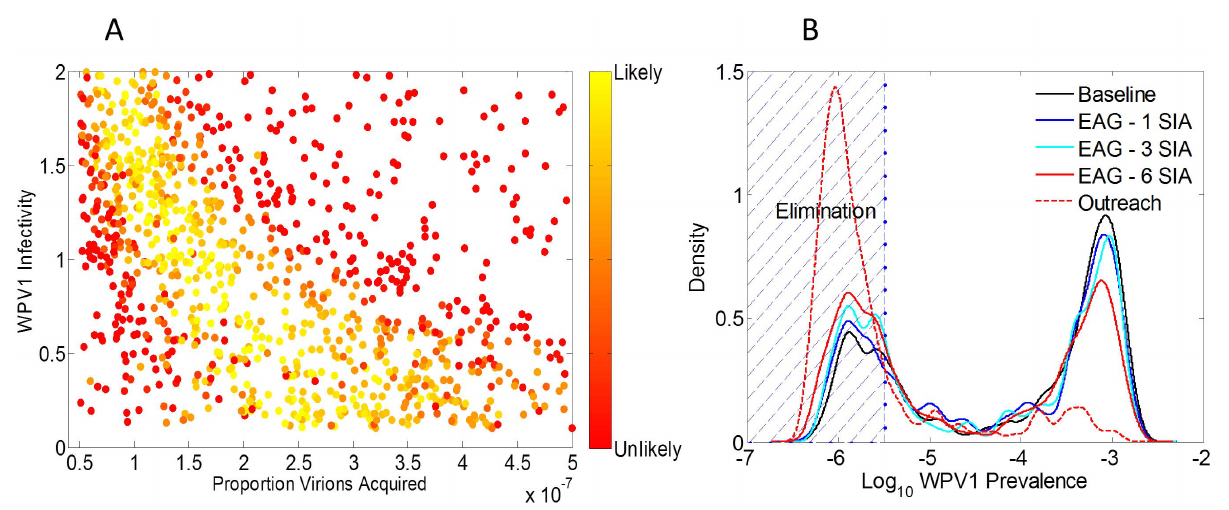
Figure 2. Model calibration and the effect of both expanding age groups and targeting in SIA campaigns. (A) Likelihood of polio infectiousness parameters: relative probability of reproducing the observed seroprevalence data from a sample of the model results conducted in the same manner (number of samples by age) as in the original Zaria serosurvey. Each tick mark represents a two-fold change in likelihood. ( B ) The effect of expanded age group SIA campaigns on elimination: distributions of mean WPV1 prevalence for baseline (calibration), EAG campaigns, and a campaign targeting hard-to- reach groups.